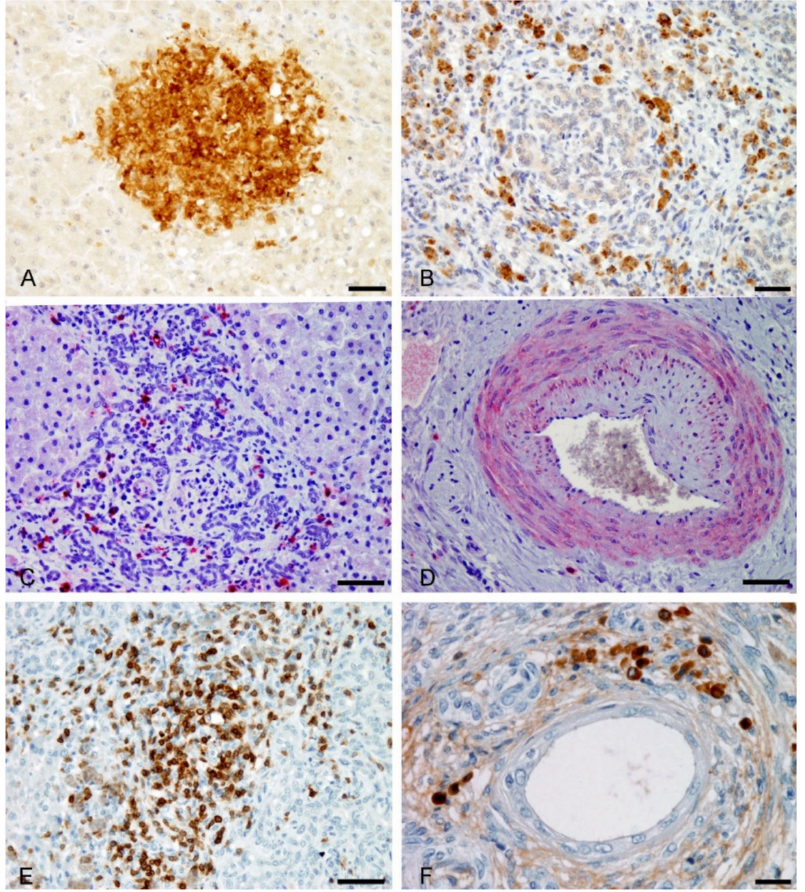
Figure 4. Immunohistochemistry in naturally acute and chronic acquired cases of FE in sheep. ( A ) Intense positive MAC387 immunolabeling of a cluster of macrophages and neutrophils in an area of cholestasis (acute lesion). Bar, 50 µ m. ( B ) Presence of CD206-+ macrophages in areas of fibrosis and ductular reaction (DR) (chronic lesion). Bar, 50 µ m. ( C ) Anti TGF- β antibody red stained cells morphologically compatible with macrophages in areas of DR (chronic lesion). Bar, 50 µ m. ( D ) Positive immunolabeling for anti TGF- β antibody in a hepatic artery with an occlusive lesion (subintimal proliferation) in chronic FE cases. Bar, 50 µ m. ( E ) Aggregates of T CD3-+ lymphocytes in areas of DR in chronic FE lesions. Bar, 50 µ m. ( F ) In chronic FE lesions IgG-+ plasma cells were seen scattered around ectatic bile ducts. Bar, 20 µ